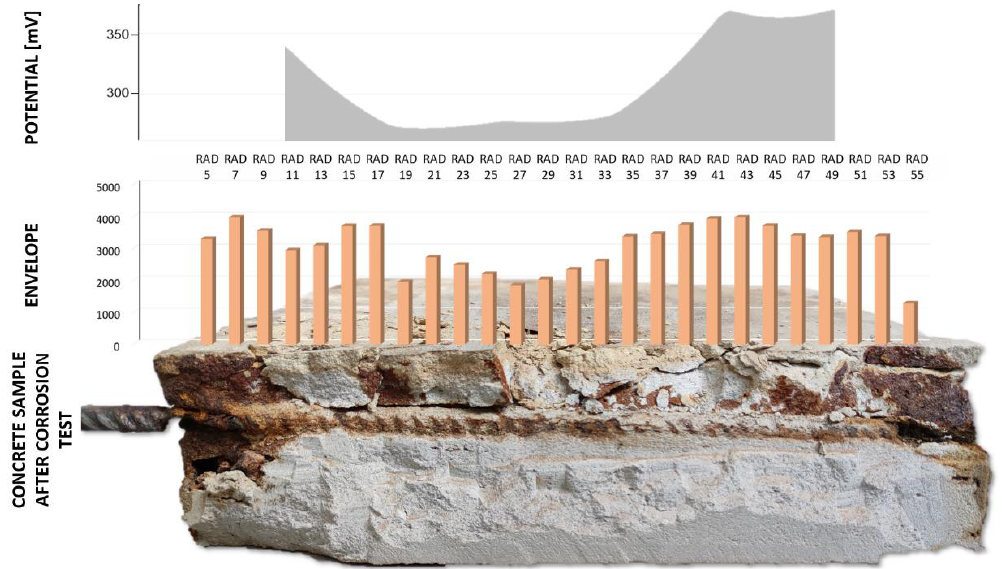
Figure 17. The histogram depicts the maximum envelope value reached for each trace at T3_10 normalized with respect to the average of the traces acquired during the first phase (T1).